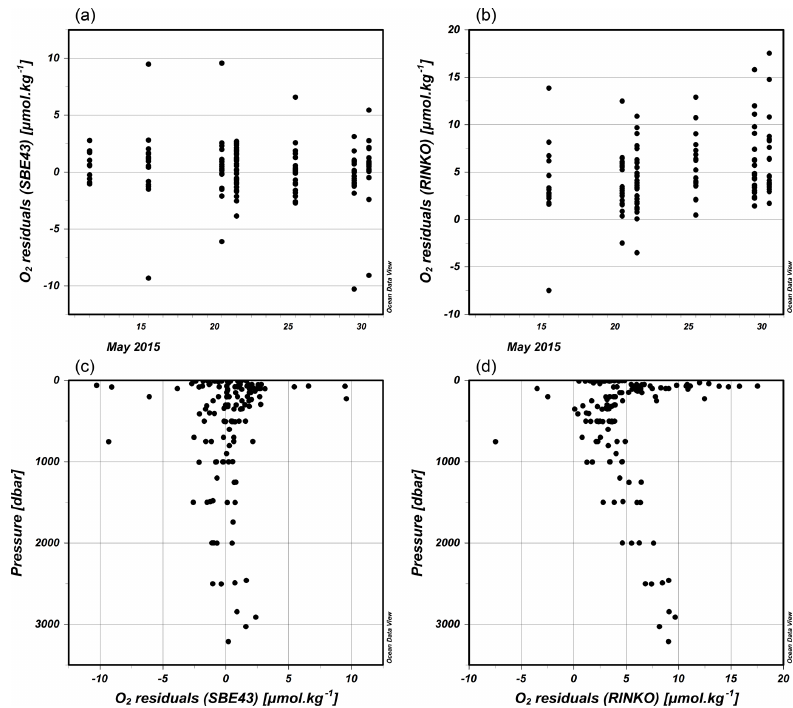
Figure 2. Oxygen residuals between sensor and Winkler measurements, plotted as a function of time (a, b) and as a function of depth (c, d) . The residuals for the electrochemical sensor are plotted in (a, c) , and those for the optode in (b, d)